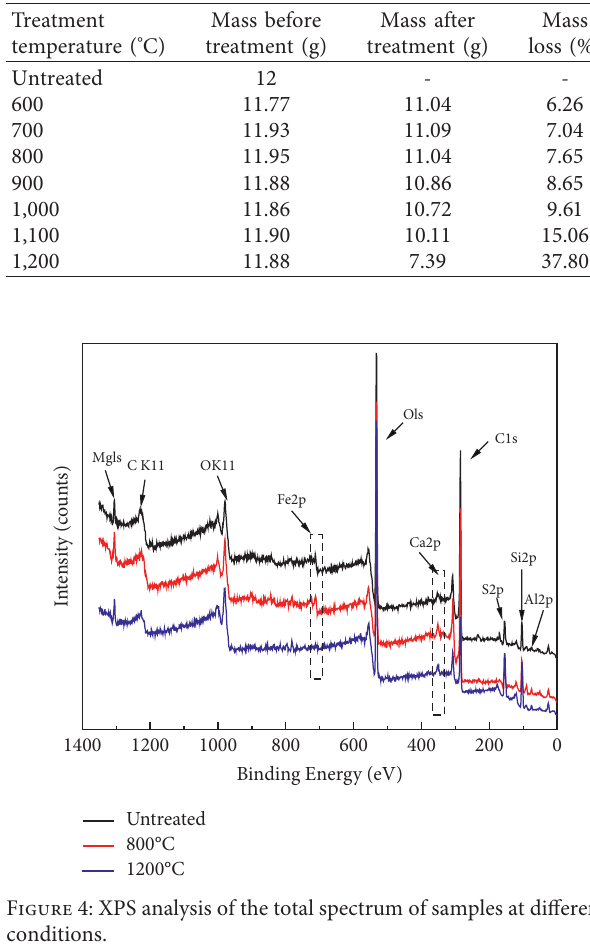
Figure 3: Schematic of the experimental setup; 1: furnace temperature controller; 2: vacuum tube furnace; 3: temperature sensor; 4: corundum boat; 5: quartz tube; 6: rubber plug; 7: valve; 8: airway; 9: Mai’s vacuum gauge; 10: sliding vane rotary vacuum pump; 11: gas collector. Table 5: Sample quality variation at different roasting temperatures.